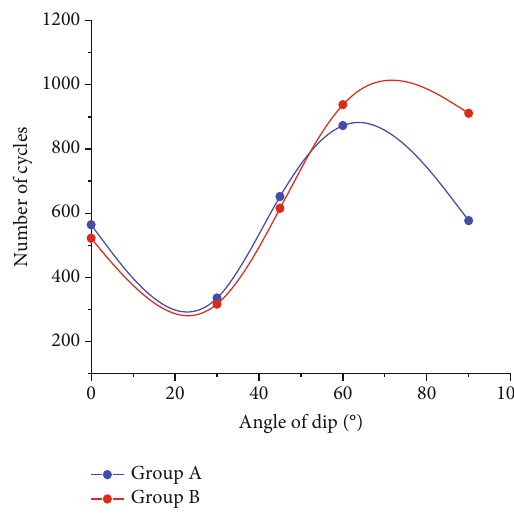
Figure 7: Variation of the number of cycles of group A and B samples as a function of the dip